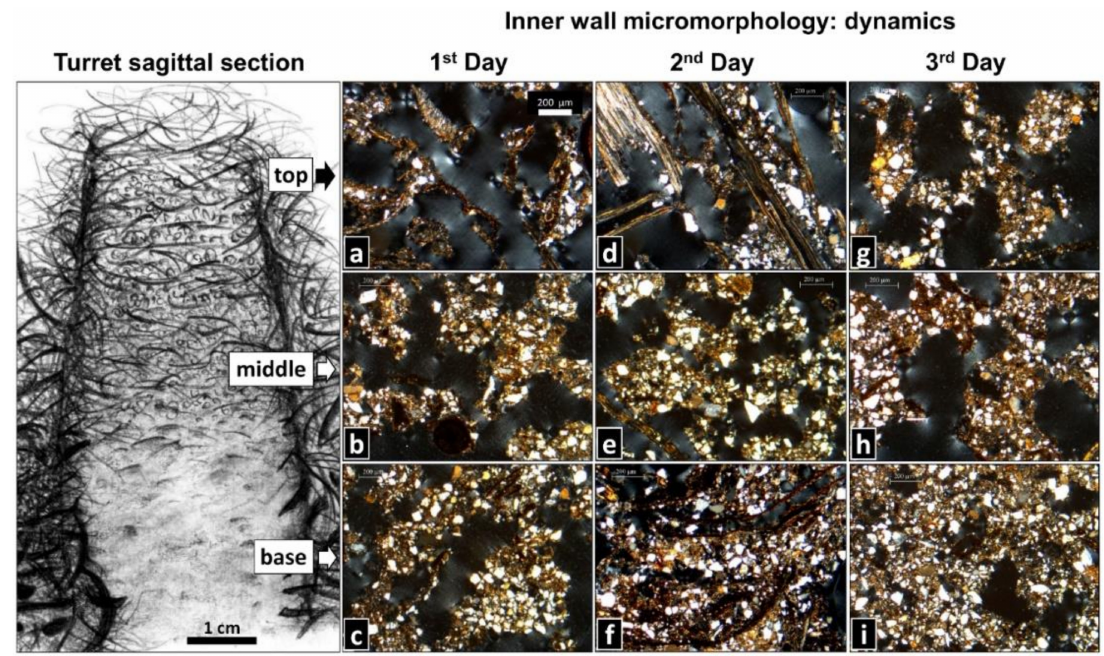
Figure 5. Building dynamics of a new turret after complete removal of the original one, over three days. Shown are the most common wall microstructures identified on thin sections (schematic drawing of a sagittal section of an entire turret by M. I. Cosarinsky). ( a ) Intermeshed plant fragments displaying a single fiber structure ( n = 5 / 10). ( b , c ) Masses of welded soil pellets cementing plant fragments, displaying a pelletal structure ( n = 6 / 10 and n = 8 / 10, respectively). ( d ) Single fiber structure ( n = 5 / 10). ( e ) Pelletal structure ( n = 5 / 10). ( f ) Mineral and organic soil materials with abundant interconnected voids, displaying a spongy structure ( n = 5 / 10). ( g , h ) Pelletal structure ( n = 5 / 10 and n = 7 / 10, respectively). ( i ) Spongy structure ( n = 7 / 10). Scale bar in ( a ) is valid for all thin sections. The frequency of occurrence of the less common inner wall micromorphological features is presented in the Supplementary Materials, Figure S3. Photo credits: M. I.